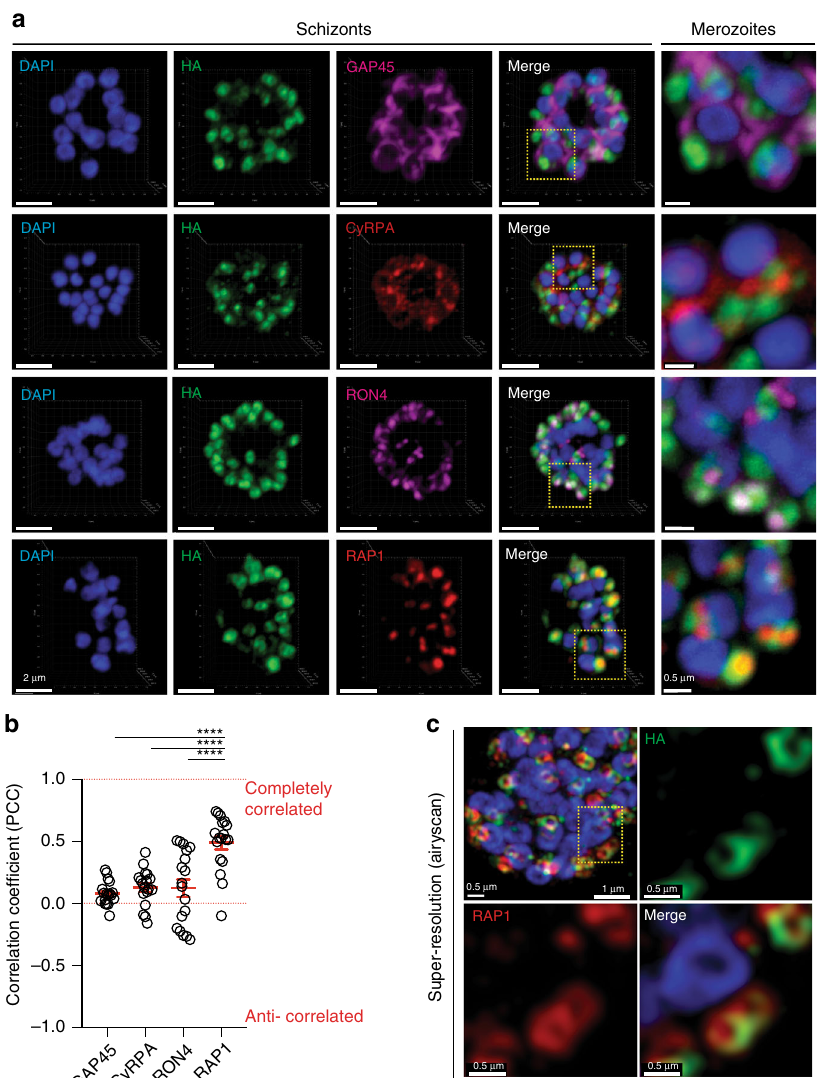
Fig. 3 PfCERLI1 localises to the rhoptry bulb of merozoites. a Immuno fl uorescence microscopy showing 3D reconstructed projections of confocal images with anti-HA (PfCERLI1) in green, colocalising more strongly with the rhoptry bulb marker RAP1 than with the micronemal marker CyRPA, rhoptry neck marker RON4 or the inner-membrane complex marker GAP45. b Quanti fi cation of the colocalisation, by Pearson ’ s correlation coef fi cient when PfCERLI1 (anti-HA) staining is de fi ned as the region of interest, with the following merozoite organelle markers: GAP45, CyRPA, RON4, and RAP1. (**** p < 0.0001 by Analysis of variance (ANOVA), n = 3 biological replicates, with 6 merozoite containing schizont images taken from each, error bars = SEM). c Maximum intensity projections of super-resolution immuno fl uorescence microscopy (Airyscan) of PfCERLI1 HAGlmS schizonts stained with anti-HA and anti-RAP1 antibodies. Yellow box (top left panel) indicates the zoom area for the free merozoite depicted in the other three